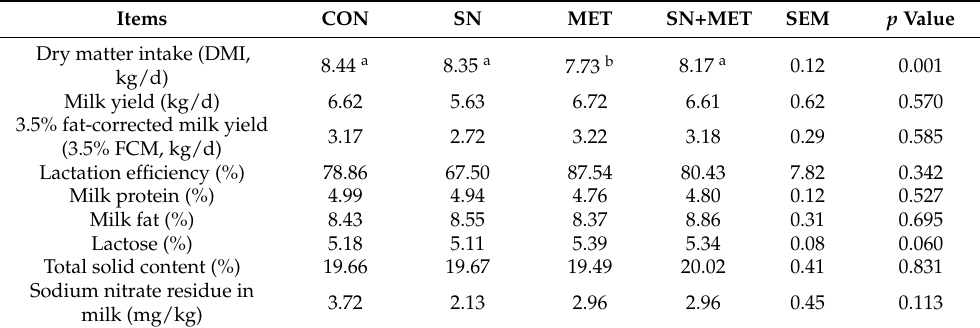
Table 2. Effects of sodium nitrate and methionine on milk yield and milk composition (N = 10).